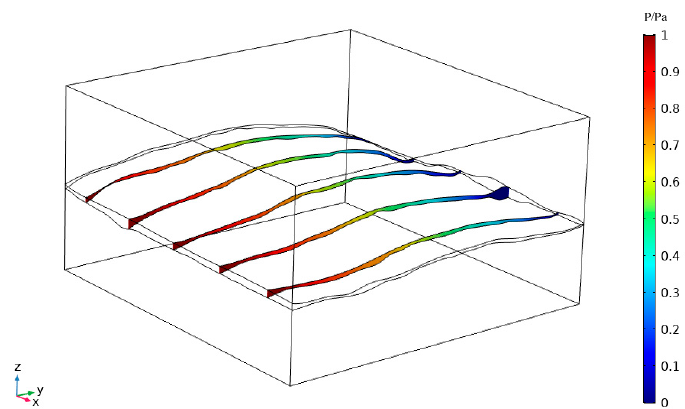
Figure 8. Temperature distribution of 3D fracture for ( a ) spatial temperature variation and ( b ) tem ‐ perature change along fracture profiles.